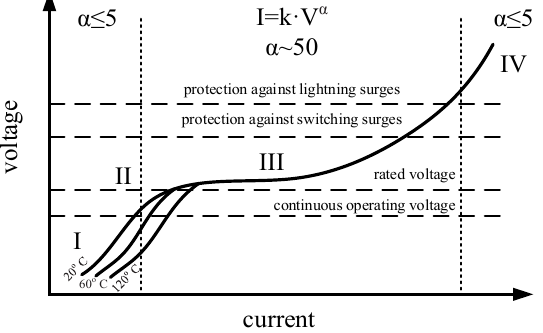
Figure 1. V–I characteristic of a typical metal oxide arrester (I: capacitive linear area, current ≤ 1 mA; II: knee point, transition from the almost-insulating to the conducting condition; III: intensely non-linear area; IV: ohmic area, high current area) [23,24].